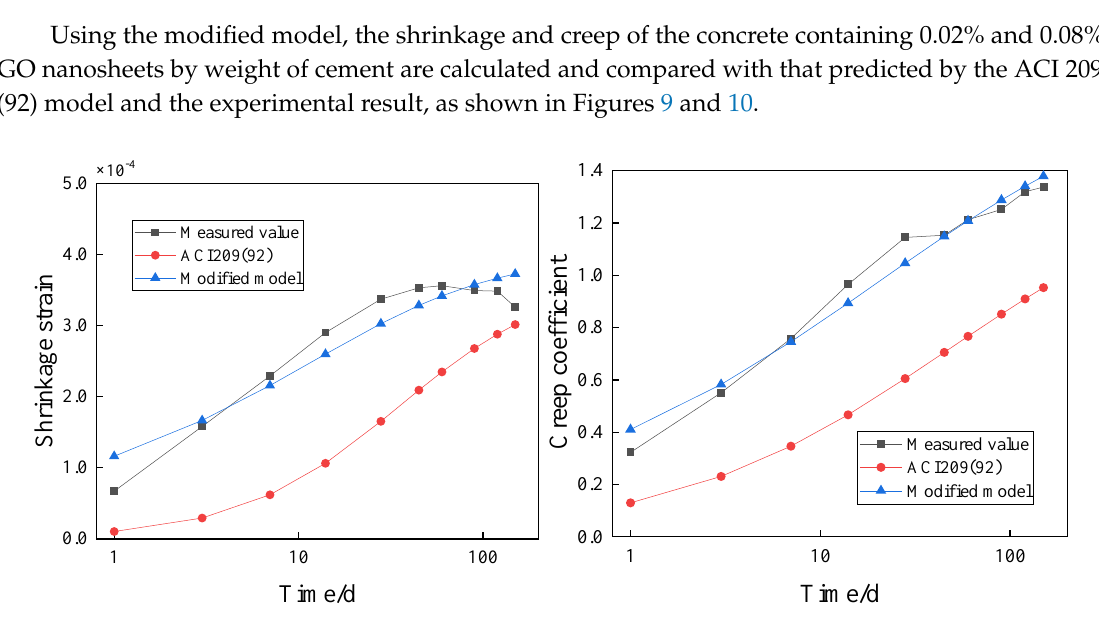
Figure 9. Comparison of shrinkage and creep models of concrete containing 0.02% GO nanosheets by weight of cement. (Note: The age of the concrete uses a logarithmic scale).